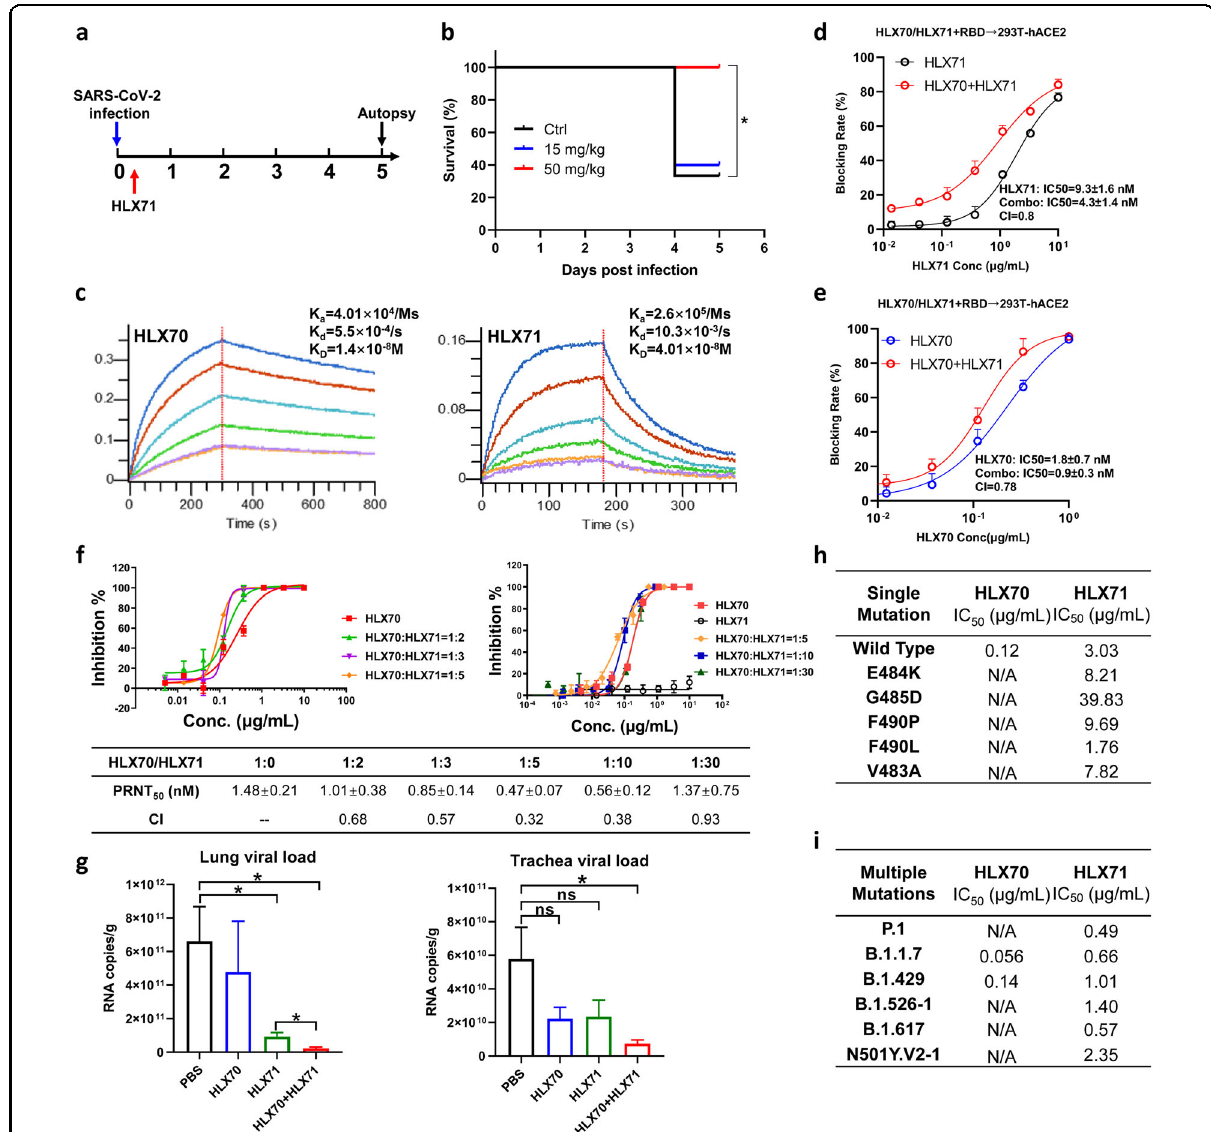
Fig. 1 Combination of HLX70 and HLX71 increased ef fi cacy in SARS-CoV-2 neutralization. a Schematic diagram for treatment schedule of HLX71 in the hACE2-transgenic mouse model. A single dose of HLX71 (15 or 50 mg/kg) or PBS control was injected intraperitoneally 2 h after the SARS-CoV-2 challenge. The mortality of the mice was recorded every day for 5 days. b Survival curve of SARS-CoV-2-infected mice treated with HLX71. * P < 0.05. c Af fi nity analysis of the binding of HLX70 (left) and HLX71 (right) to SARS-CoV-2 RBD. d RBD-blocking activity of HLX71 is enhanced by HLX70. HLX70 (0.05 μ g/mL) was mixed with serially diluted HLX71 and incubated with RBD-His. The mix was then added to the 293T-hACE2 cell suspension, and an anti-His-PE antibody was used for detection. CI (combination index) values were calculated by CompuSyn software. e RBD- blocking activity of HLX70 is enhanced by HLX71. HLX71 (0.5 μ g/mL) was mixed with serially diluted HLX70 and incubated with RBD-His. The blocking rate was measured the same way as d . f HLX70 was mixed with HLX71 at the ratio of 1:2, 1:3, 1:5, 1:10, and 1:30. Threefold serial dilutions of the mixes were added to ~500 PFU of SARS-CoV-2 virus solution, and the neutralization potency was assessed in Vero cells using PRNT. The x axis shows the concentrations of the HLX70. g In vivo ef fi cacy of HLX70 + HLX71 combination. BALB/c mice were treated with HLX70 ( n = 5), HLX71 ( n = 5), or HLX70 + HLX71 combination ( n = 5) 2 h after infection of 1.6 × 10 4 PFU of MASCp6. Five days after the virus challenge, mice were sacri fi ced to analyze the virus burden in the lung and trachea. Virus titer was demonstrated as RNA copies per gram tissue. ns, not signi fi cant; * P < 0.05. h HLX71 neutralization activity against HLX70-resistant SARS-CoV-2 pseudovirus mutants. i Neutralization activity of HLX70 and HLX71 against pseudoviruses with multiple